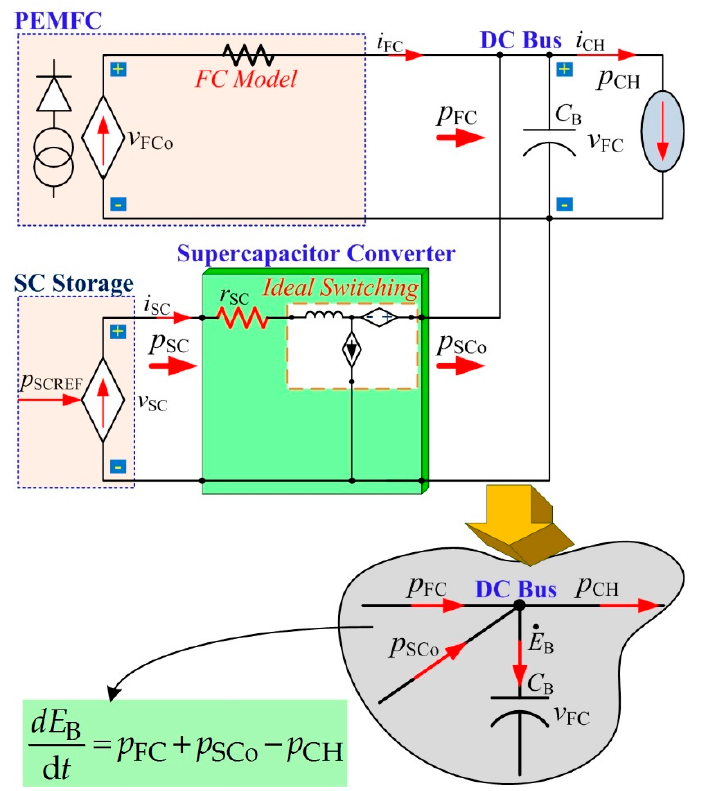
Figure 10. Reduced-order model of the system.